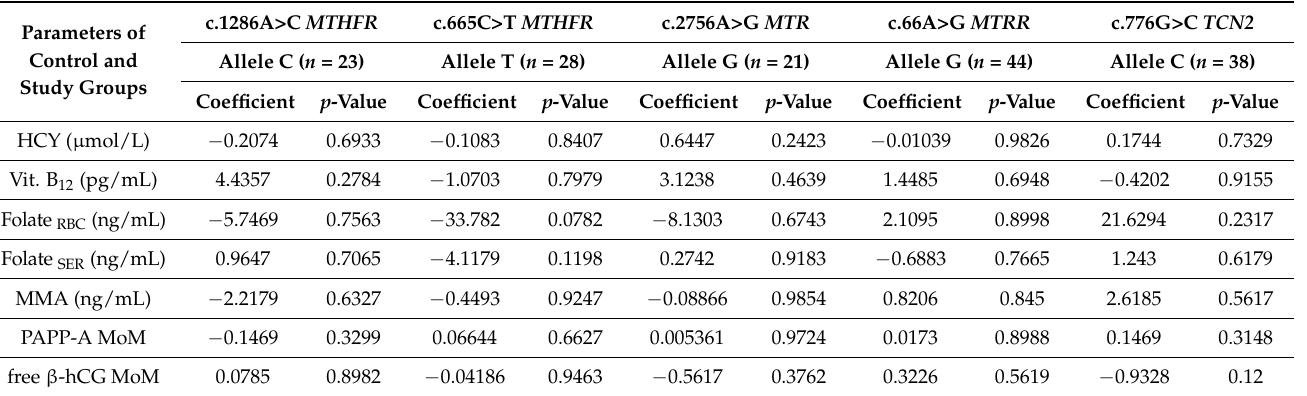
Table 4. Assessment of the relationship between the occurrence of alternative alleles in both hetero- and homozygous systems with the concentrations of the studied biochemical parameters based on the analysis of the multivariate regression model.